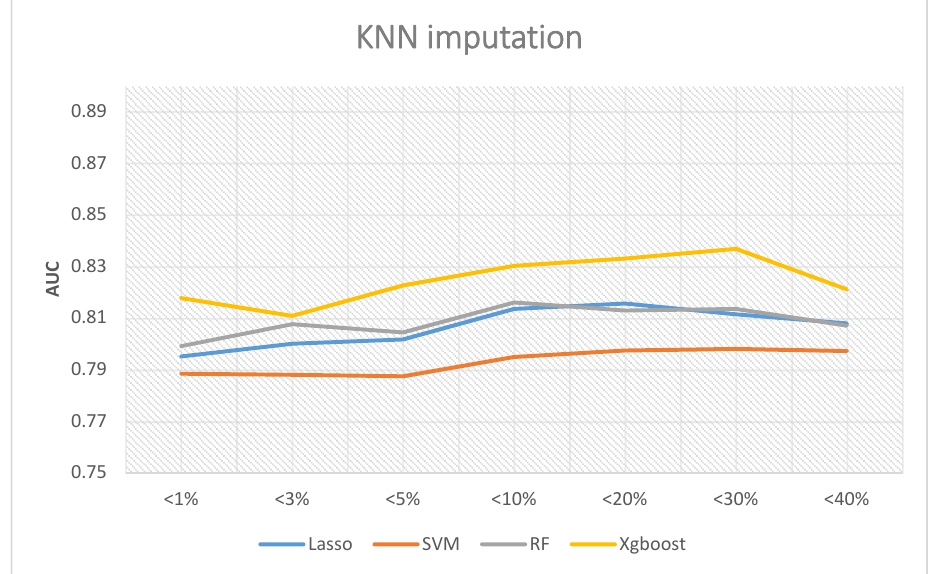
Figure 6. AUC with KNN imputation.